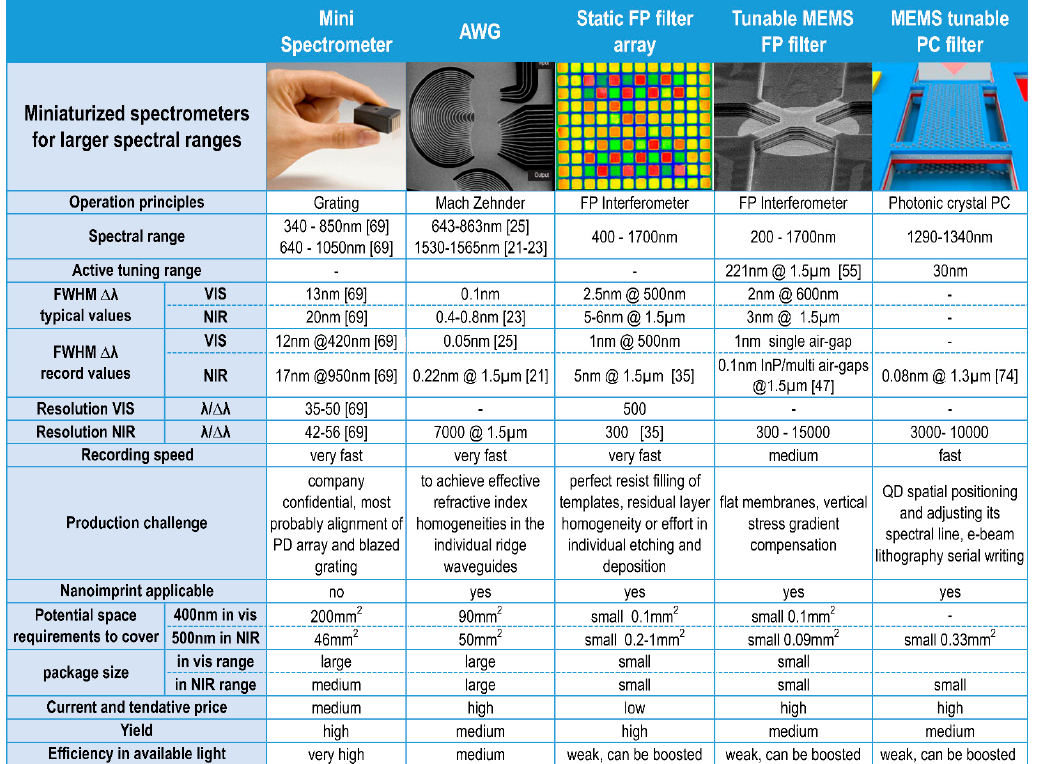
Table 1. Benchmarking a selection of different miniaturized spectrometers. The characteristics compared comprise mainly optical properties, but also economic and manufacturing points. The wavelength λ denotes the vacuum wavelength. AWG = arrayed waveguide grating, FP = Fabry–P é rot, MEMS = microelectromechanical system, QD = quantum dot, FWHM = full width of half